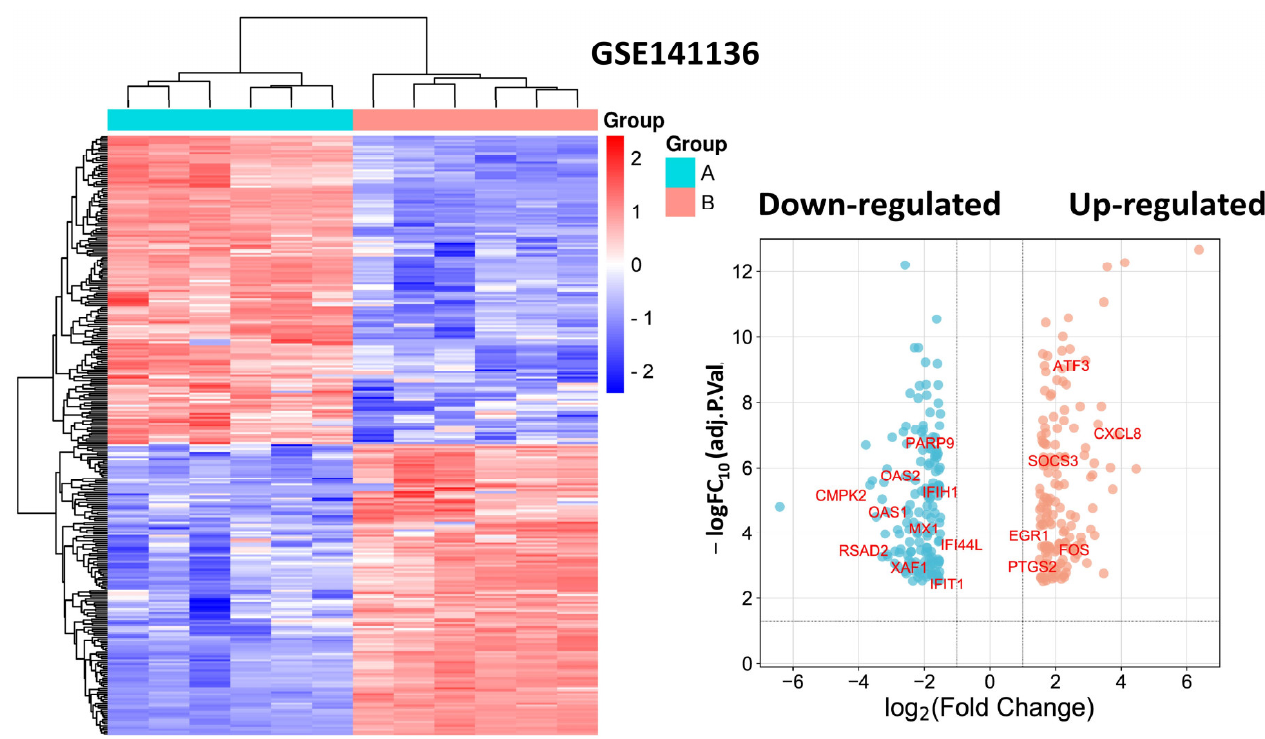
Figure 5. Heatmap and volcano plot for DEGs from dataset GSE141136. Note: the identified hub DEGs are shown in the volcano plot.